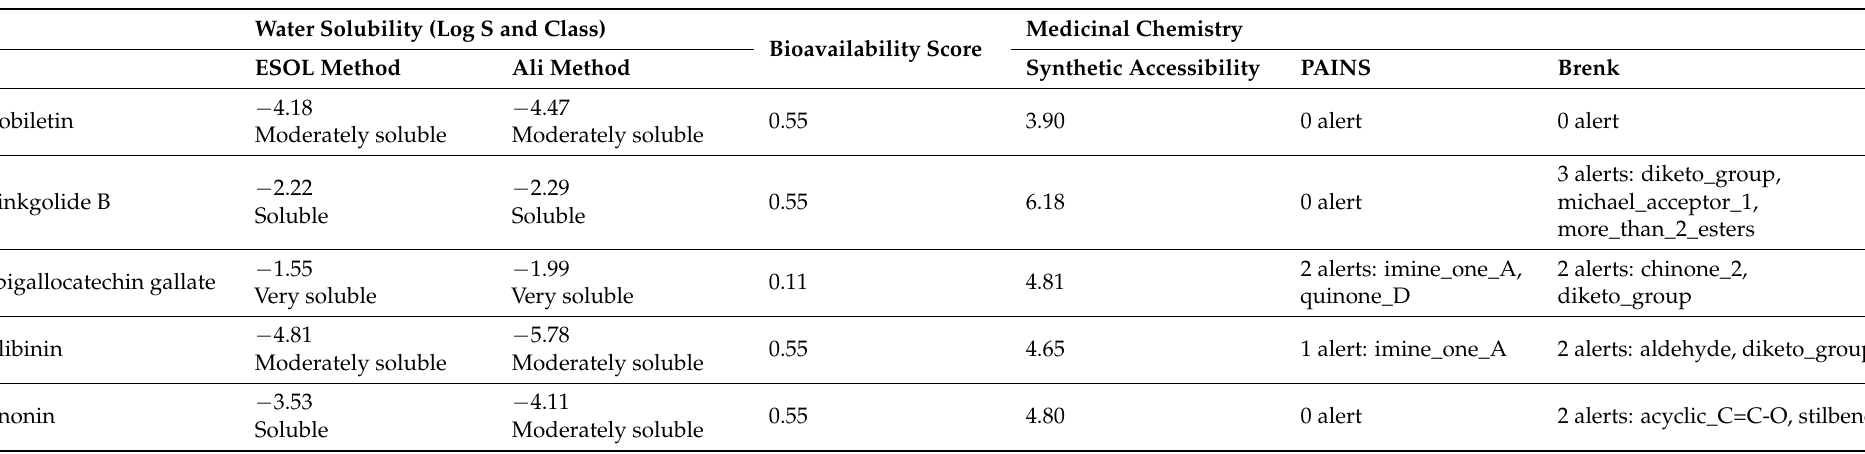
Table 4. Physiochemical, lipophilicity, water-solubility, drug likeliness, and medicinal chemistry properties of nobiletin, ginkgolide B, silibinin, ononin, and epigallocatechin gallate.